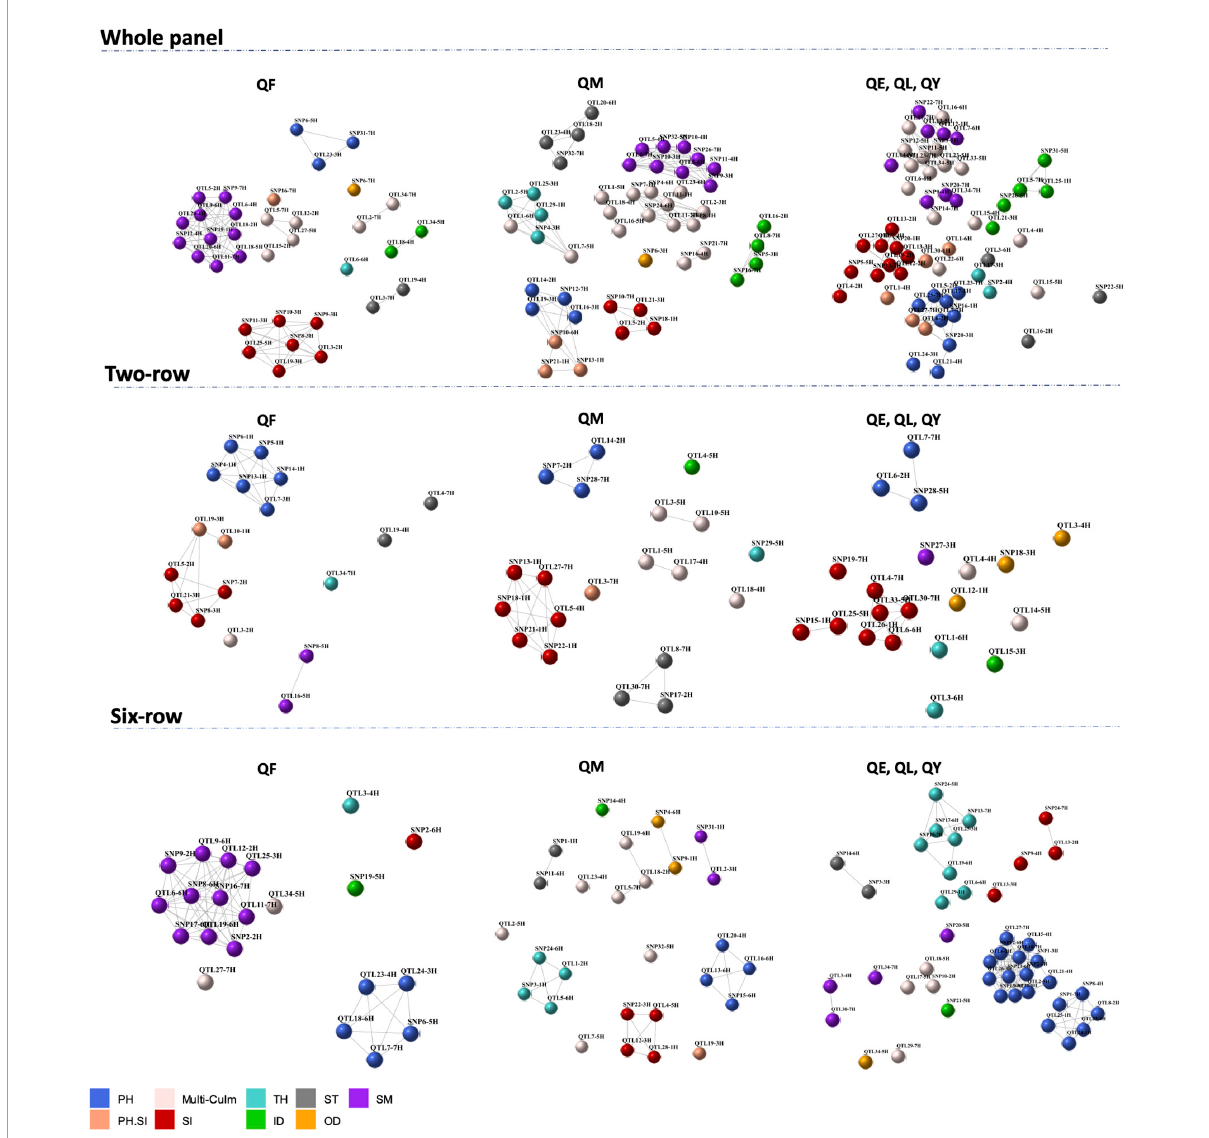
FIGURE3 Co-association network representing co-association modules between 192 loci across whole panel and row type subsets, with color schemes according to the phenotypic traits. Each node is an SNP/QTL and a color according to its association with the corresponding trait. Strong co-associations with a correlation above threshold ( r = 0.9) are connected by edges. PH, plant height; OD, outer diameter; ID, inner diameter; TH, thickness; SM, section modulus; ST, stiffness; SI, stem index; multi-culm stands for loci associated with multiple culm traits; PH.SI stands for loci associated with both PH and SI. QF indicates markers with main but also interaction effects; QM indicates markers with main effects and stable across environments; QE indicates marker-by-environment effect; QL indicates marker-by-location effect; QY indicates marker-by-year